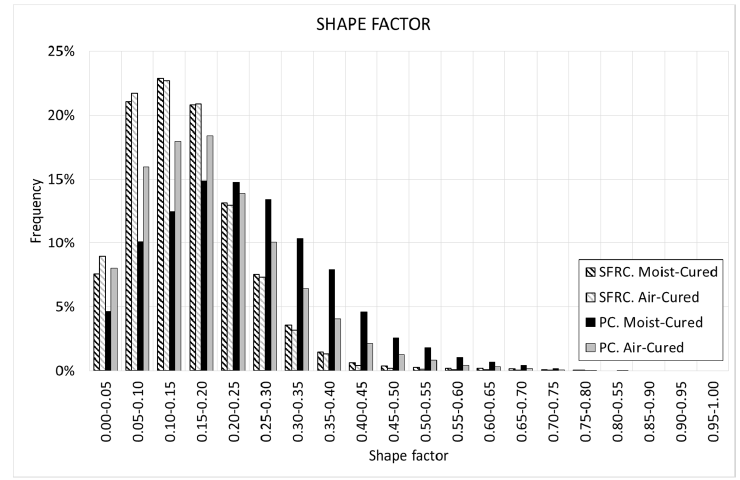
Figure 10. Histogram of the shape factor.